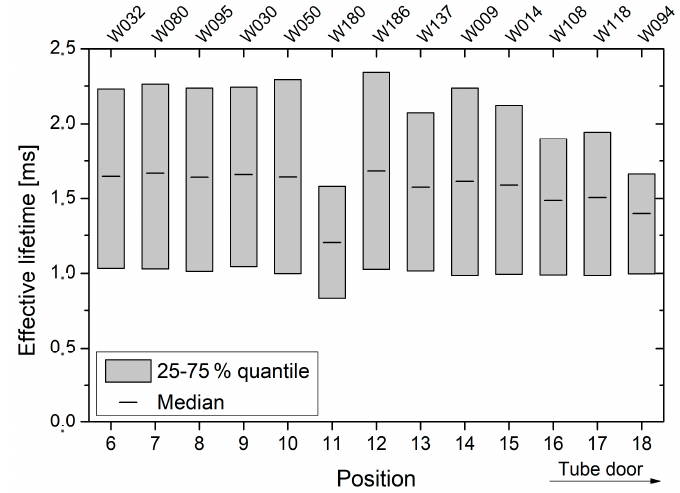
Figure 8. For oxidation run ε , effective lifetimes are shown as a function of quartz boat position and wafer number, respectively. The quartz boat positions 6–18 contained only 150 mm wafers from batch A, whereby quartz boat position 18 is located in direction of the tube door.